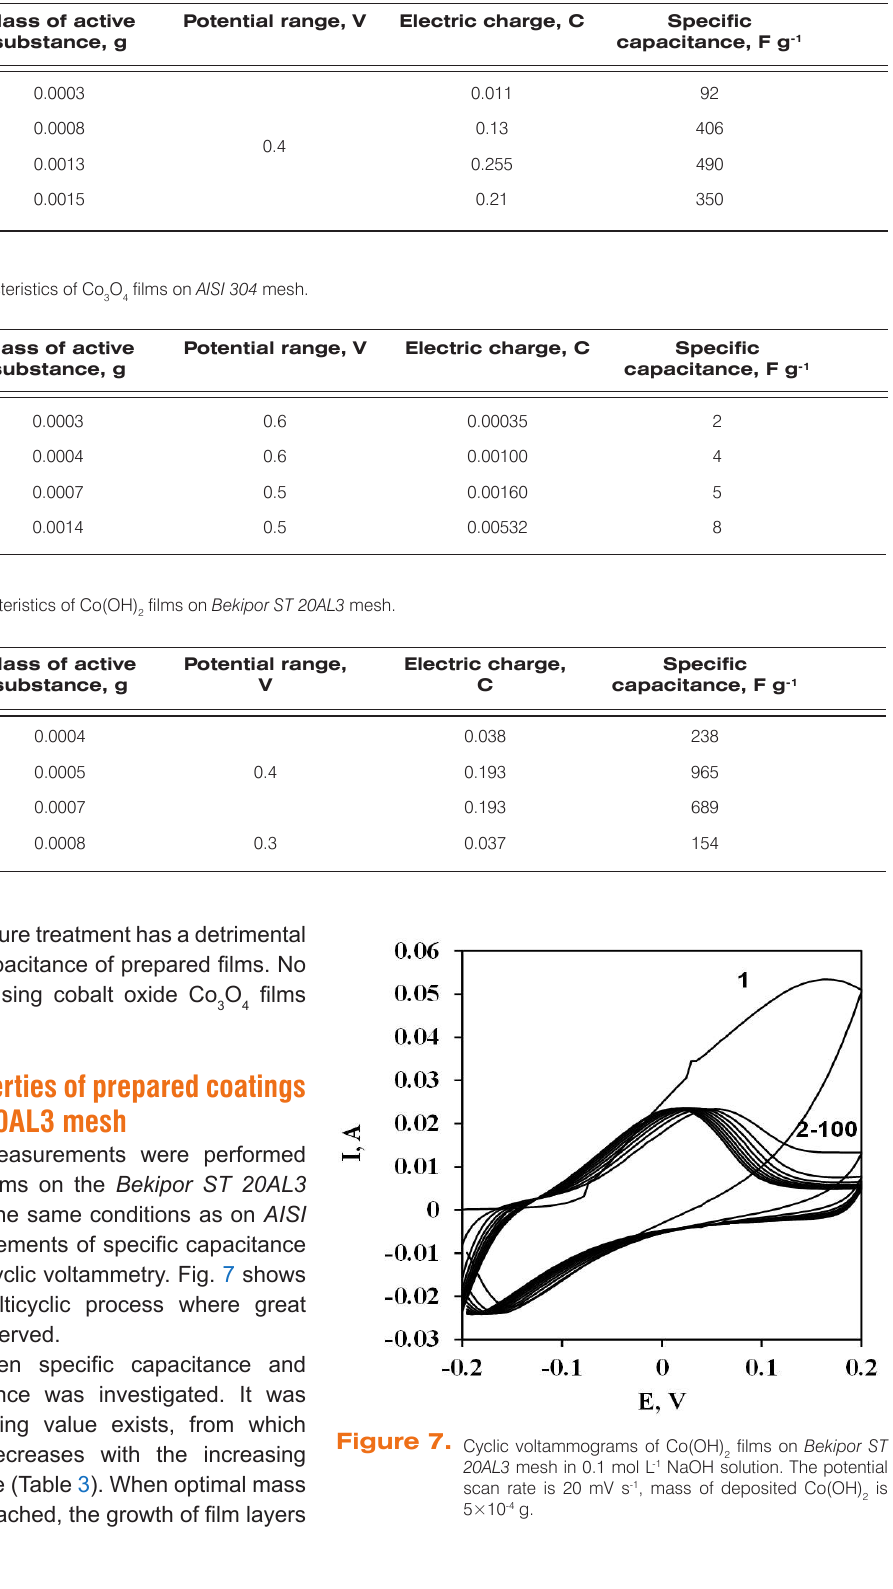
films on AISI 304 type stainless steel. 2